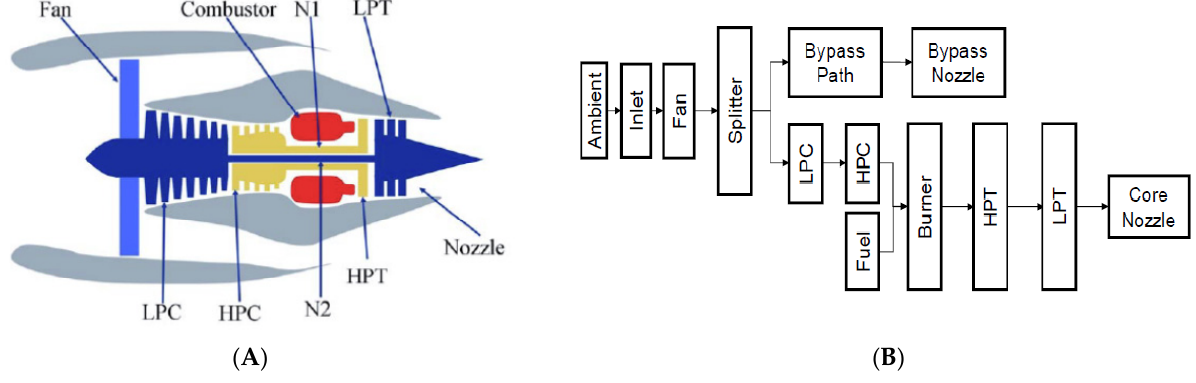
Figure 7. The simulated turbofan engine based on C-MAPSS [32] (images courtesy of NASA). ( A ) Simplified diagram of the turbofan engine; ( B ) Turbofan engine modules layout and